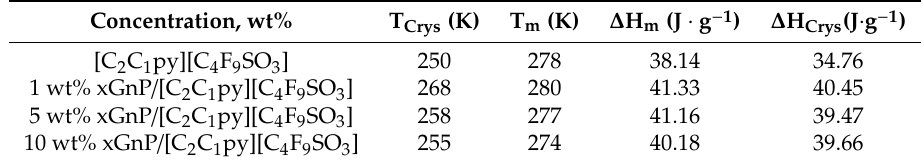
Table 3. Crystallization, T Crys , and melting, T m , temperatures, latent heat of fusion, ∆ H m , and latent heat of crystallization, ∆ H Crys of xGnP / [C 2 C 1 py][C 4 F 9 SO 3 ] obtained with heating and cooling rates